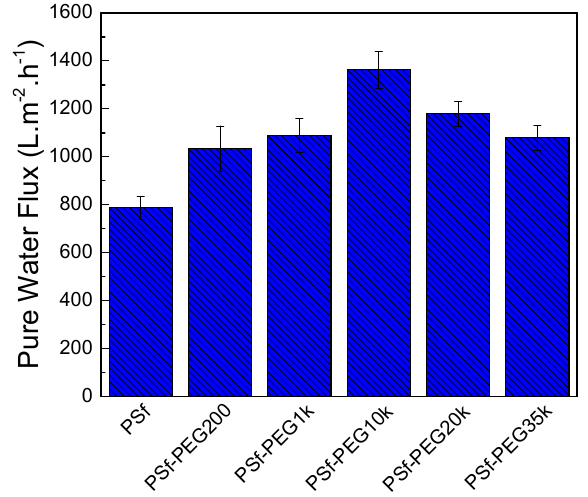
Figure 4. Water flux of PSf supports prepared using PEG of varying molecular weights at 0.6 MPa.